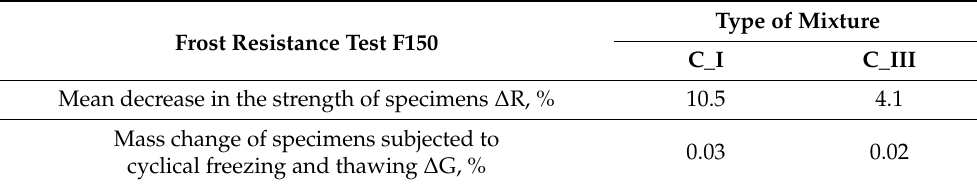
Table 9. Influence of the cement type on frost resistance after 28 days of